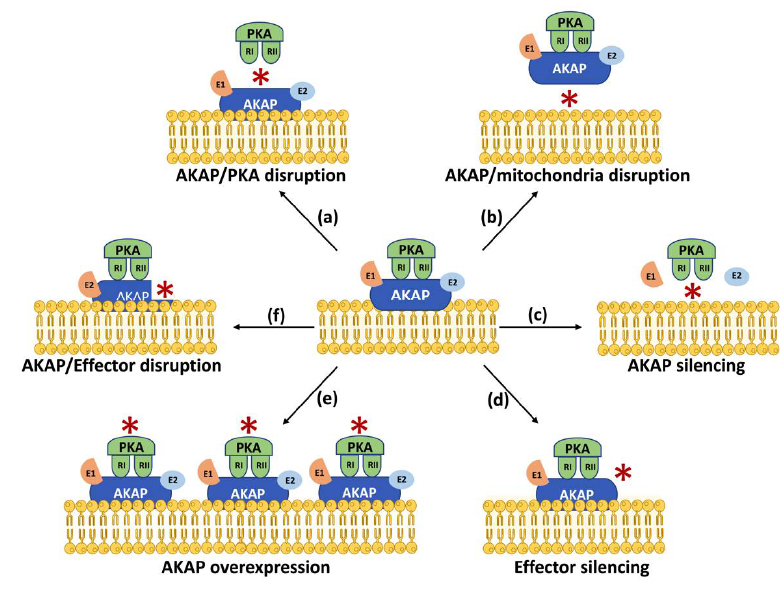
Figure 2. Strategies to modulate AKAP signaling. Schematic representation of different strategies to modulate AKAPs signaling: ( a ) disruption of AKAP/PKA interaction; ( b ) disruption of AKAP/mi- tochondria interaction; ( c ) silencing of effector molecules; ( d ) AKAP silencing; ( e ) AKAP overex- pression and ( f ) disruption of AKAP/effectors complexes. Red asterisk (*) indicates the site of mod- ulation.